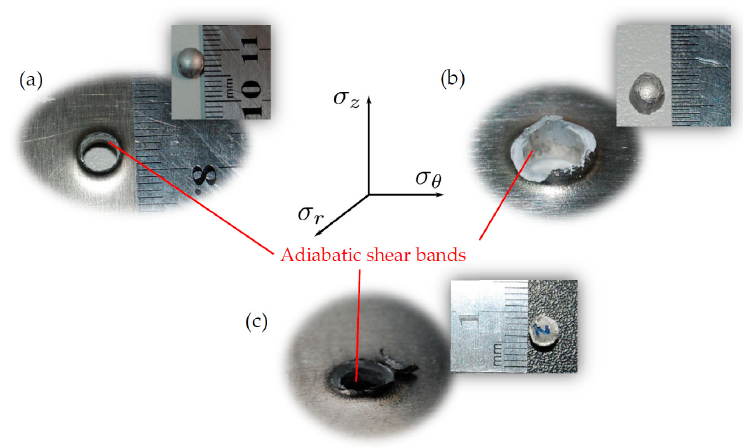
Figure 13. Experimental results: blunt projectile configuration. The final stage of the impact process for: ( a ) AA 6082-T6; ( b ) AA 5754-H111; ( c ) AA2024-T351.